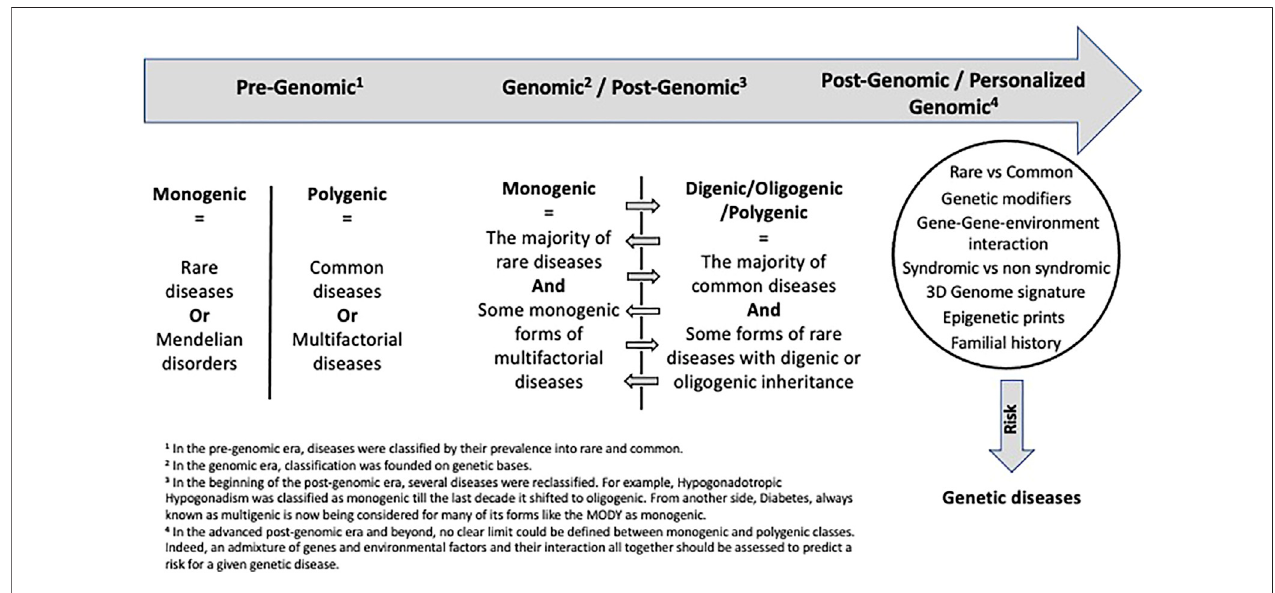
FIGURE 1 | Evolution of disease classi fi cation through genomic